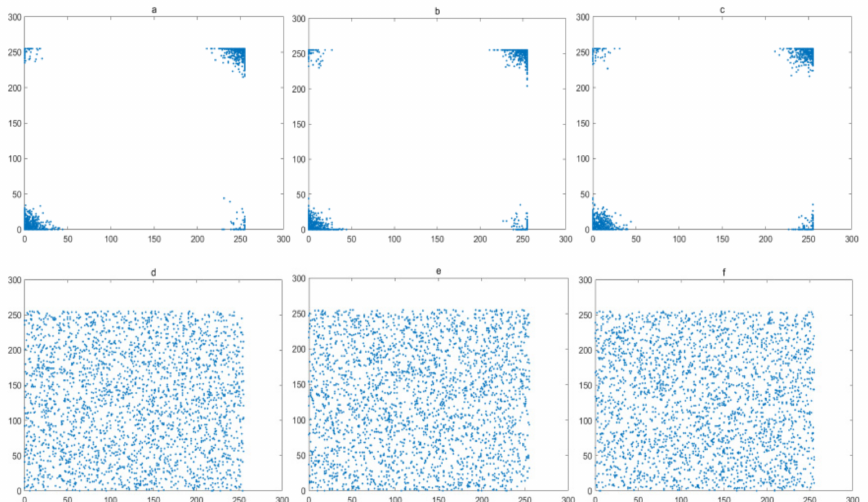
Figure 19. Correlation analysis of Granules image: ( a – c ) horizontal, vertical and diagonal direction of plain-text image; ( d – f ) horizontal, vertical and diagonal direction of